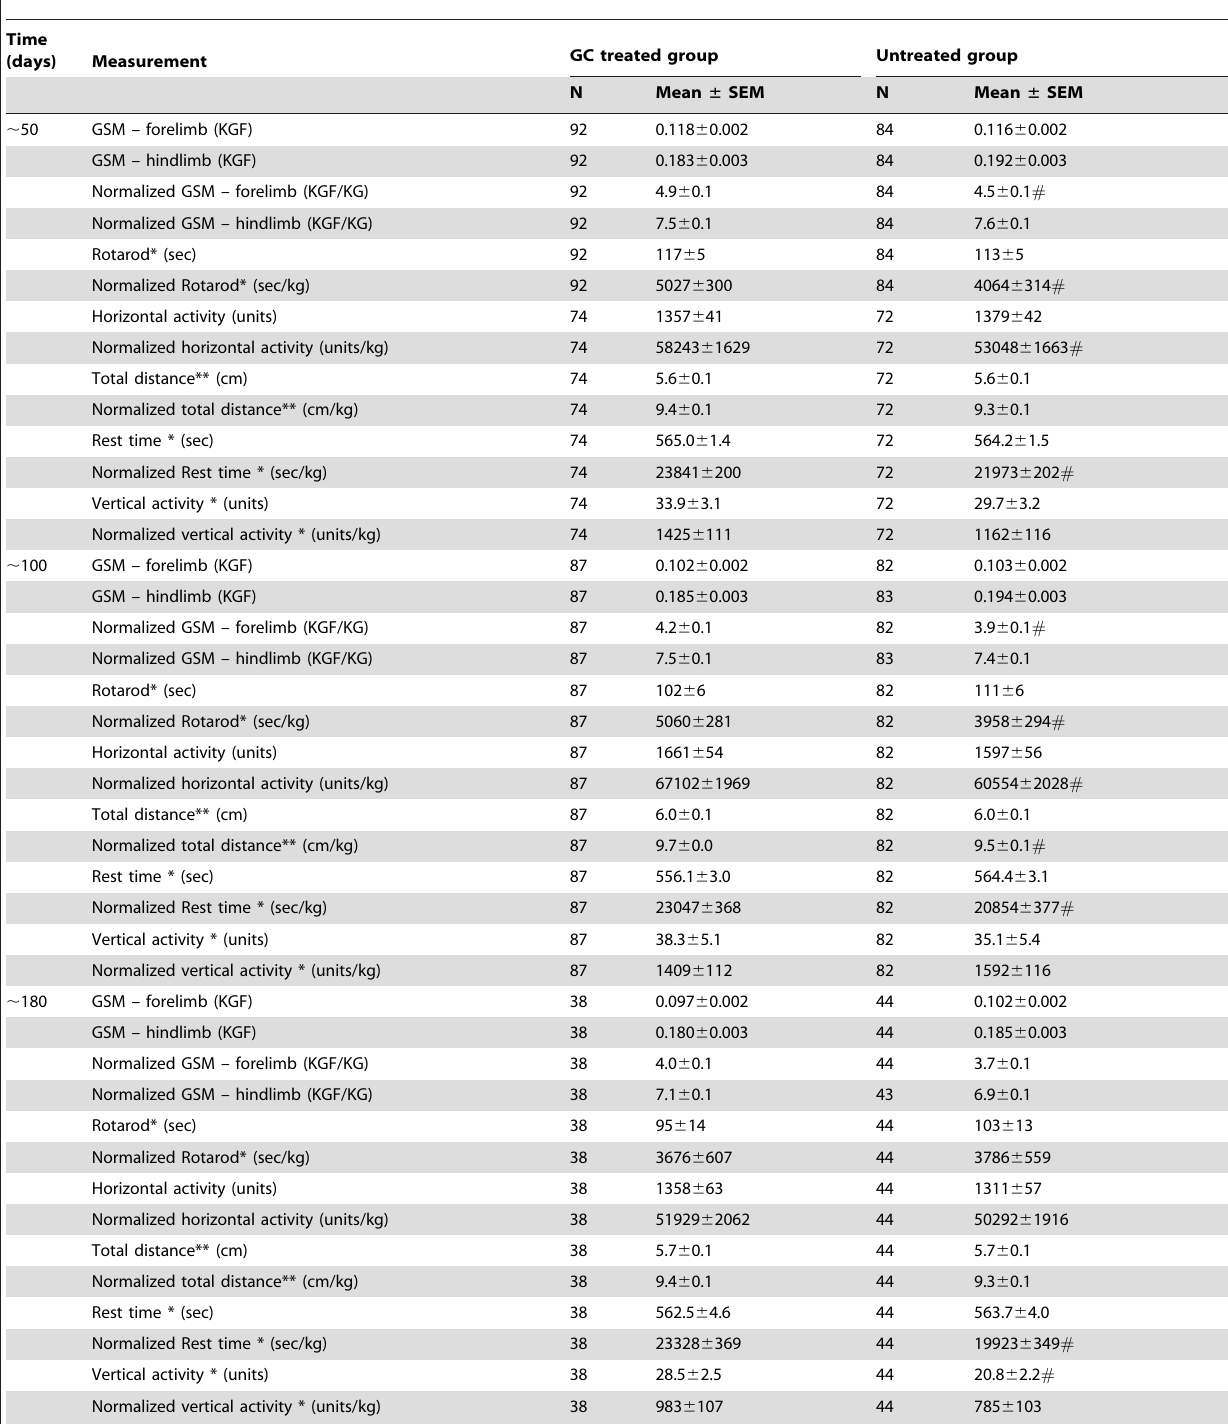
Table 2. Grip strength, motor, and behavioral measurements in untreated and GC-treated mice